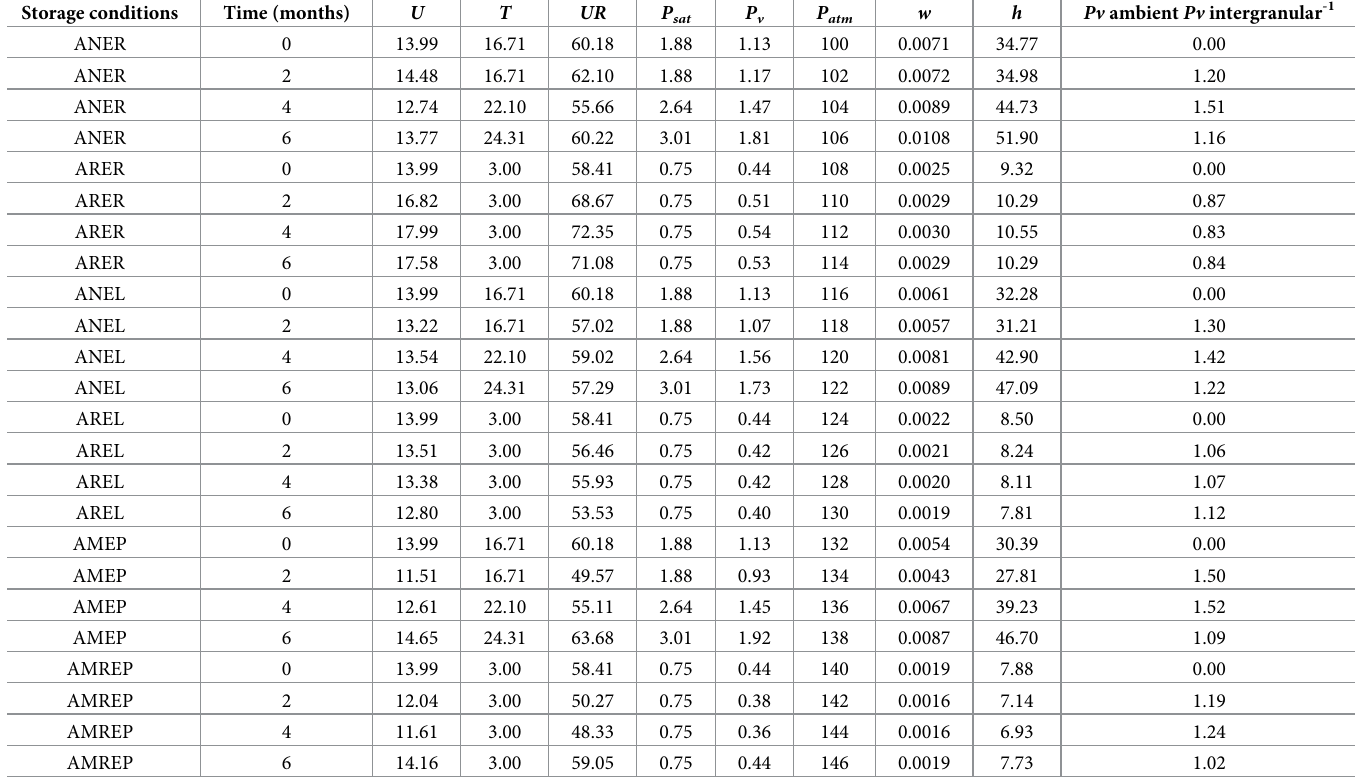
Table 3. Characterization of RR soybean seeds and conditions storage. Storage